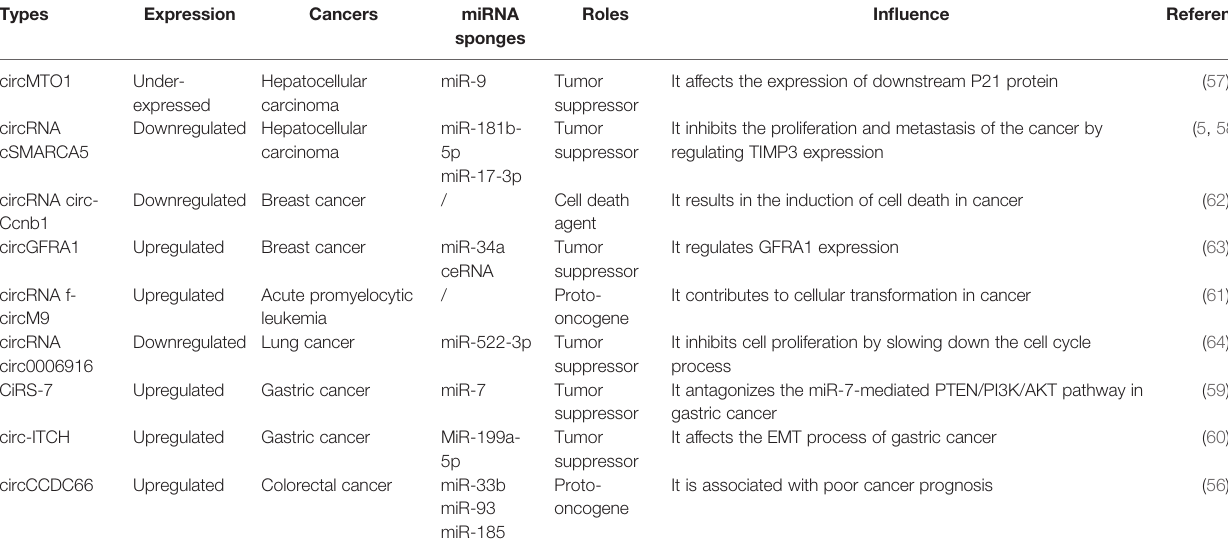
TABLE 1 | Some circRNA types in